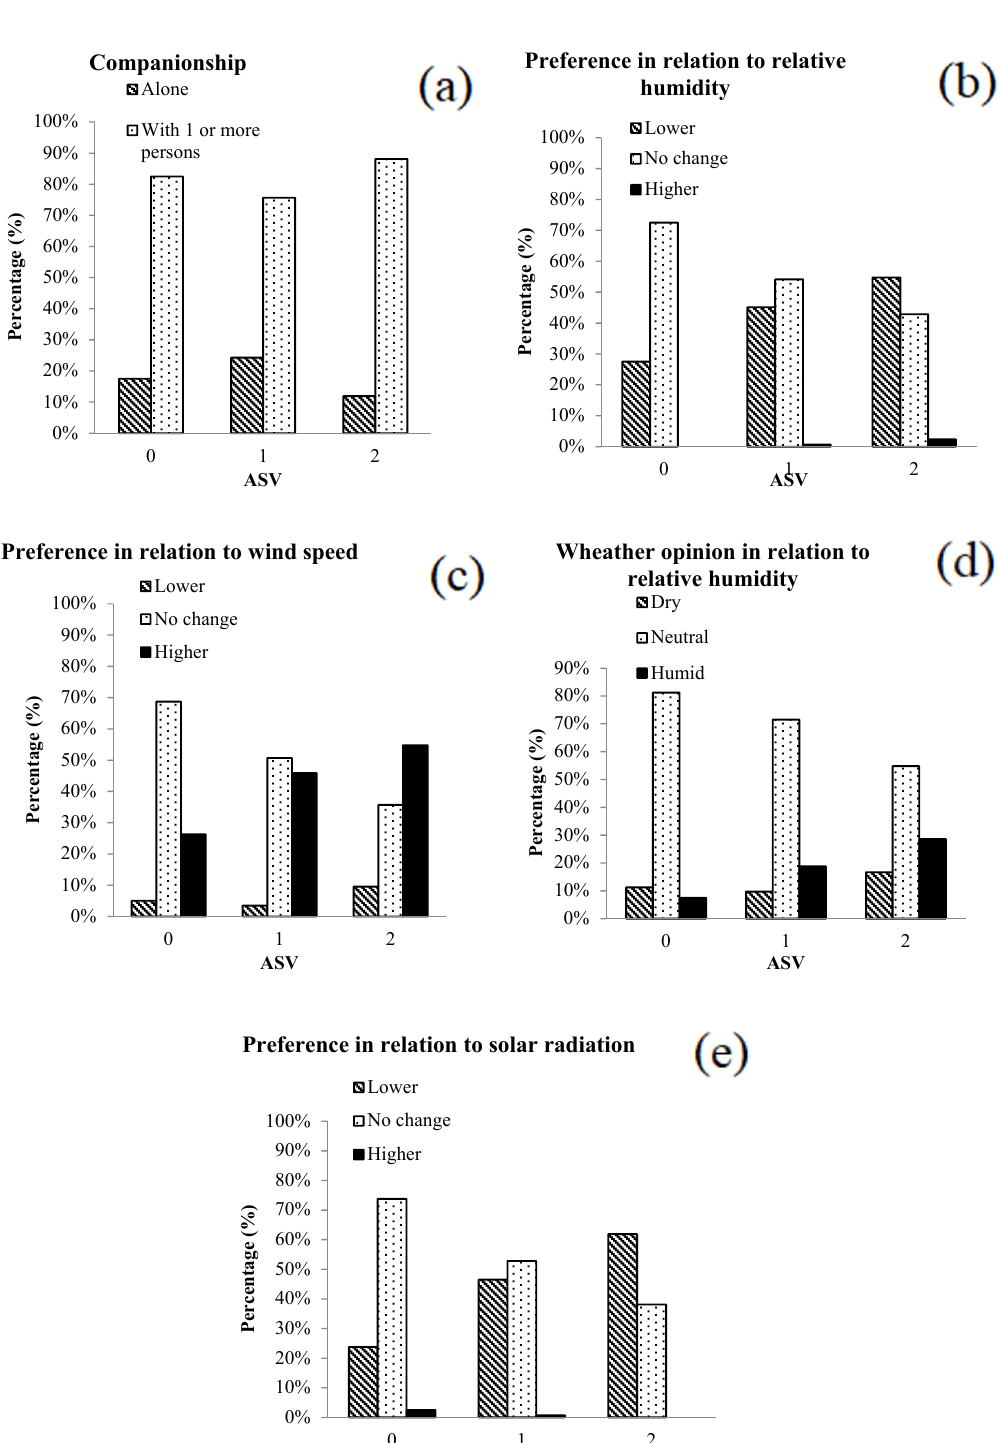
Figure 10. Psychological parameters per class of Actual Sensation Vote.